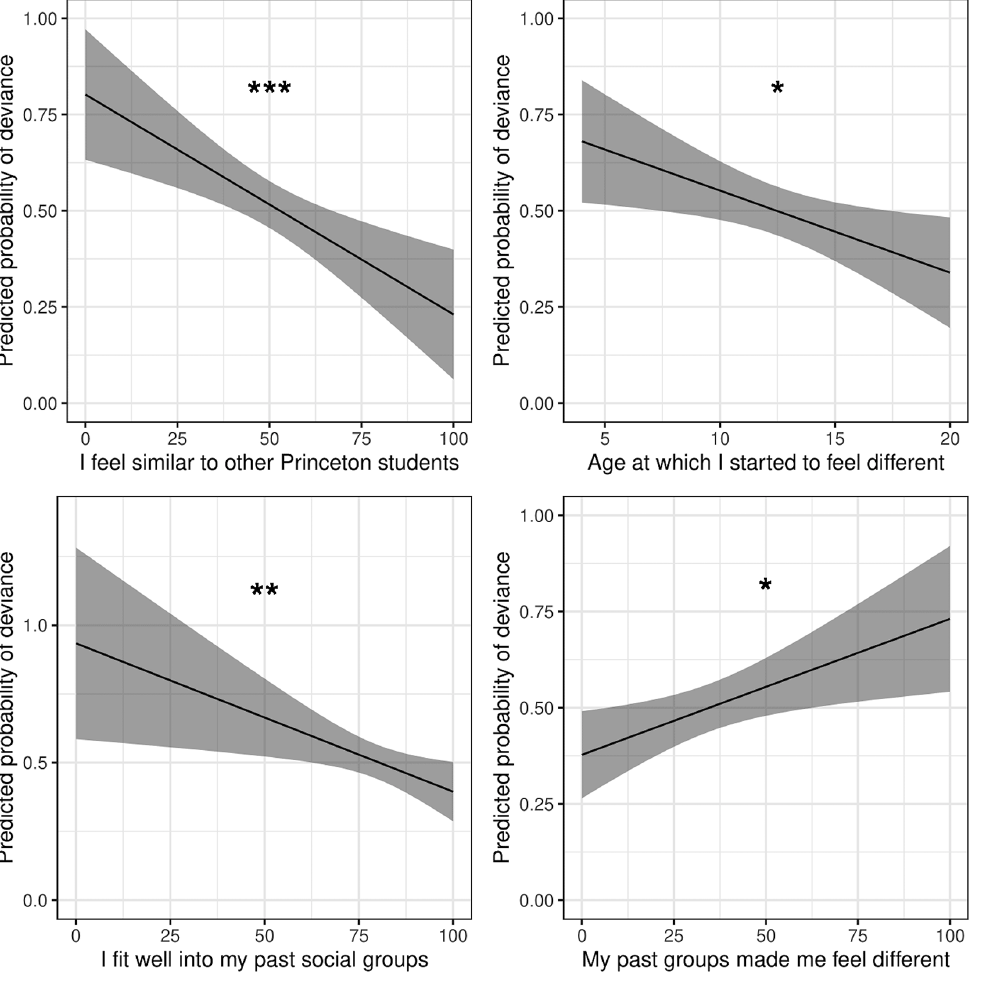
Figure 2. Predicted probability of deviance from the eating club norm, based on separate regressions of the binary eating club deviance item on each self-reported item of deviance as status in the past and present, controlling for demographic variables set at their